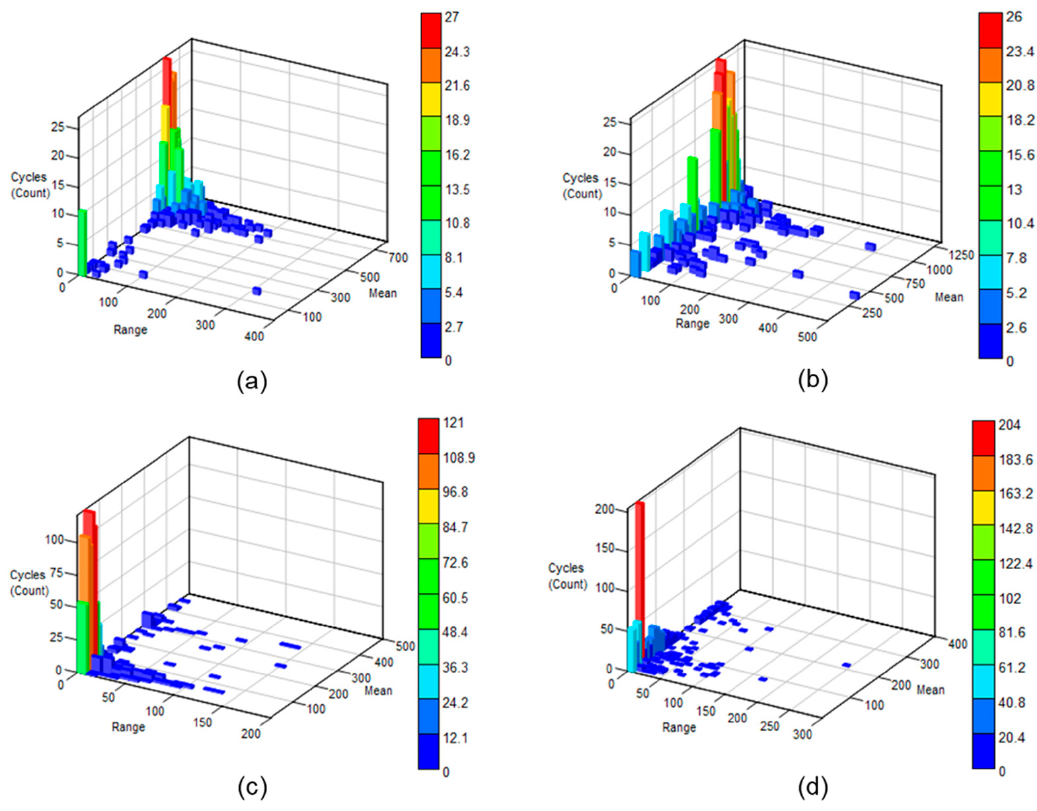
Figure 8. Load spectra for the spiral bevel gear by field operations: ( a ) moldboard plow tillage, ( b ) subsoiler tillage, ( c ) rotary tillage, and ( d ) baler operation.